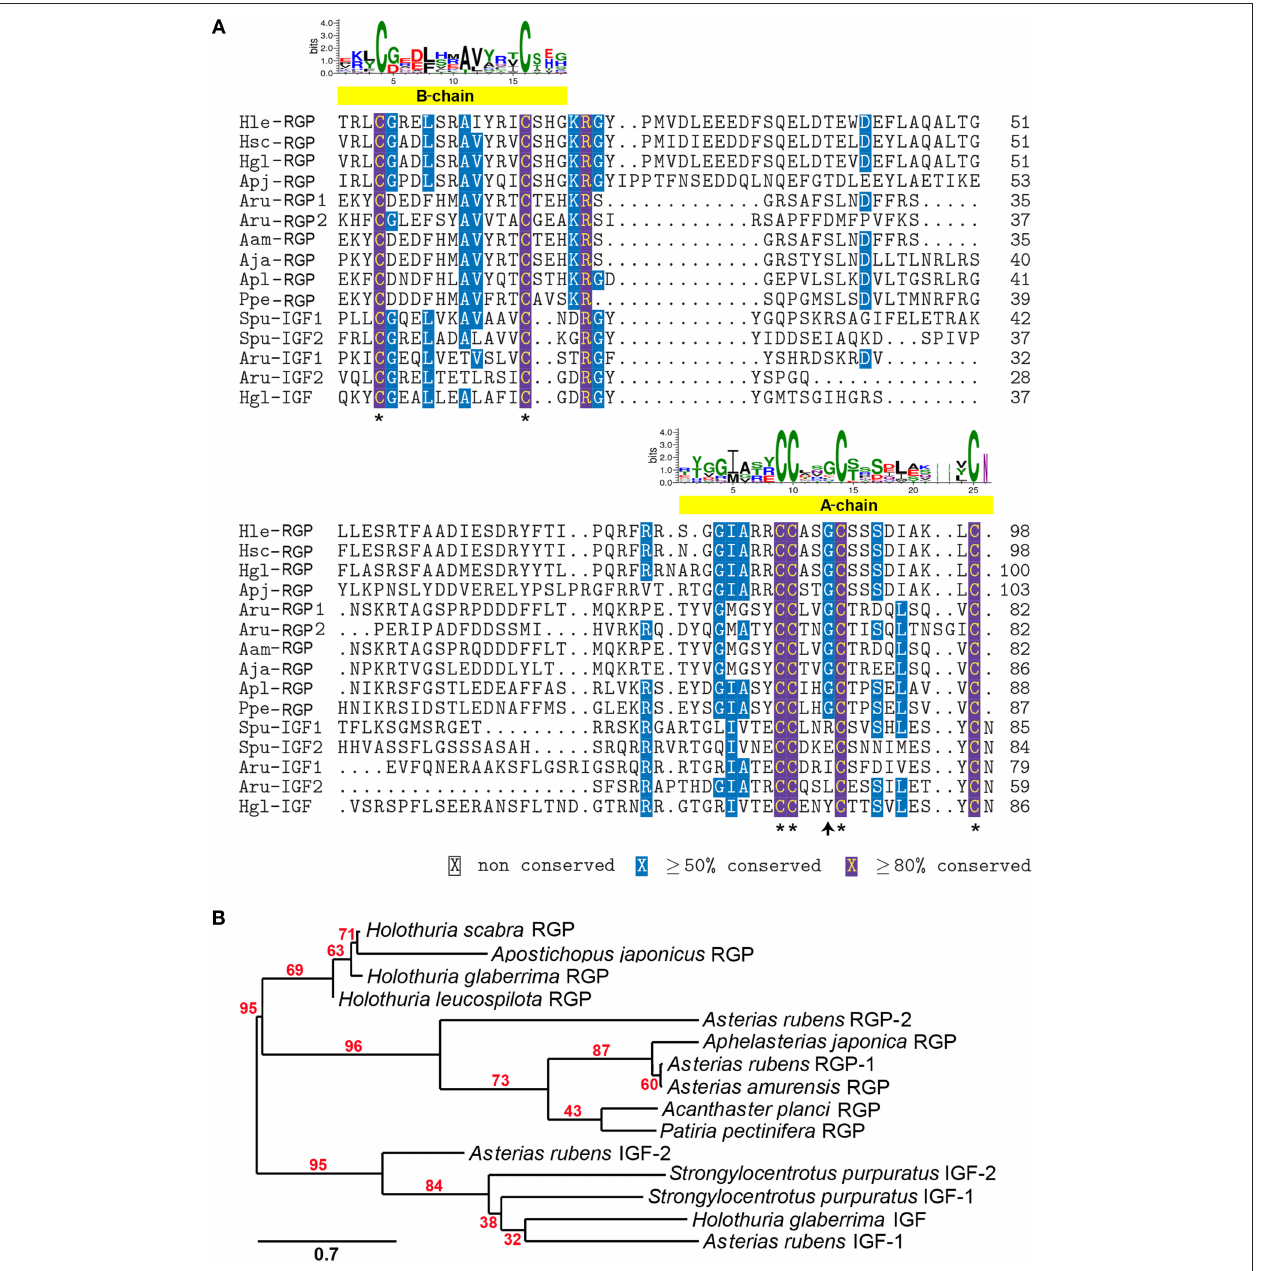
FIGURE 2 | Multiple sequence alignment and phylogenetic tree analysis of echinoderm RGP/IGF mature peptides. (A) Alignment of echinoderm RGP/IGF mature peptides. The yellow bars indicate the putative A- and B-chain peptides which contain the highly conserved cysteine residues (asterisks) important for disulphide bridge formation. The sequence logo above the alignment shows the conservation of amino acid composition at each position. (B) Phylogenetic tree analysis of sea cucumber and other echinoderm RGP mature peptides based on maximum likelihood estimation (500 bootstraps). The echinoderm IGFs were used as the outgroup. The numbers above nodes indicate the branch support values. The scale bar indicates the estimated amino acid substitutions per site. For species abbreviations and sequences used in the amino acid alignment and phylogenetic tree, see Supplementary Data S1